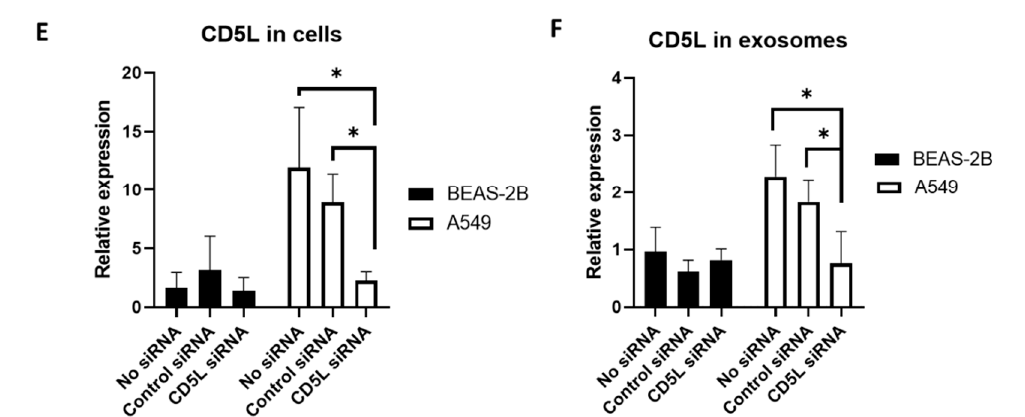
Figure 6. Transfection of siCD5L into BEAS-2B and A549 cells. ( A ) CD5L mRNA expression analyzed by RT-qPCR. ( B ) Glyceraldehyde 3-phosphate dehydrogenase (GAPDH) mRNA expression analyzed by RT-qPCR. ( C ) CD5L protein expression in parent cells analyzed by Western blotting. ( D ) CD5L protein expression in EVs analyzed by Western blotting. ( E ) Quantitative analysis of CD5L by Western blotting in cells. ( F ) Quantitative analysis of CD5L by Western blotting in EVs. No siRNA, control group without transfection of siRNA; Control siRNA, cells transfected with control siRNA as negative control; GAPDH siRNA, cells transfected with GAPDH siRNA as positive control; CD5L siRNA, cells transfected with CD5L siRNA. * p < 0.05.